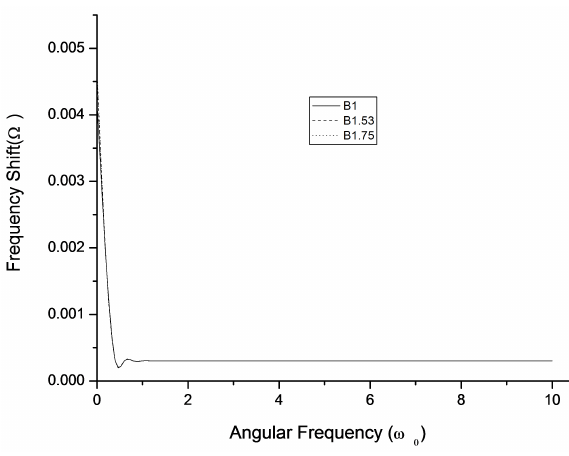
Figure 9: Variation in frequency shift with respect to angular fre- quency ( α = 1)